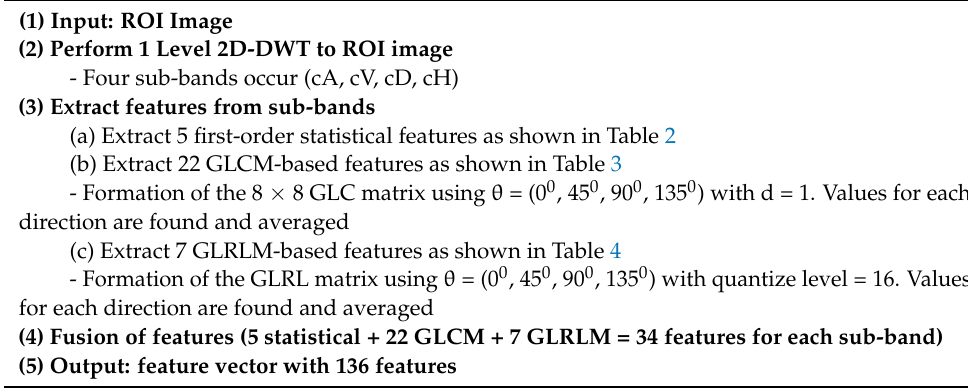
Algorithm 2 Feature extraction process